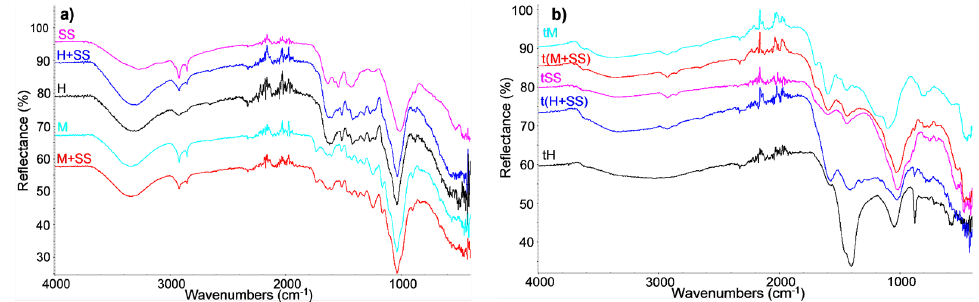
Figure 7. FTIR spectra of ( a ) raw samples and ( b ) torrefied samples (350 °C, 60